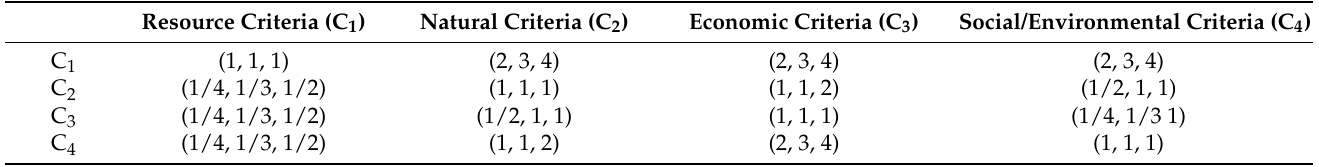
Table A2. Fuzzy pairwise comparison matrix of expert 2 (Weight: 0.3).